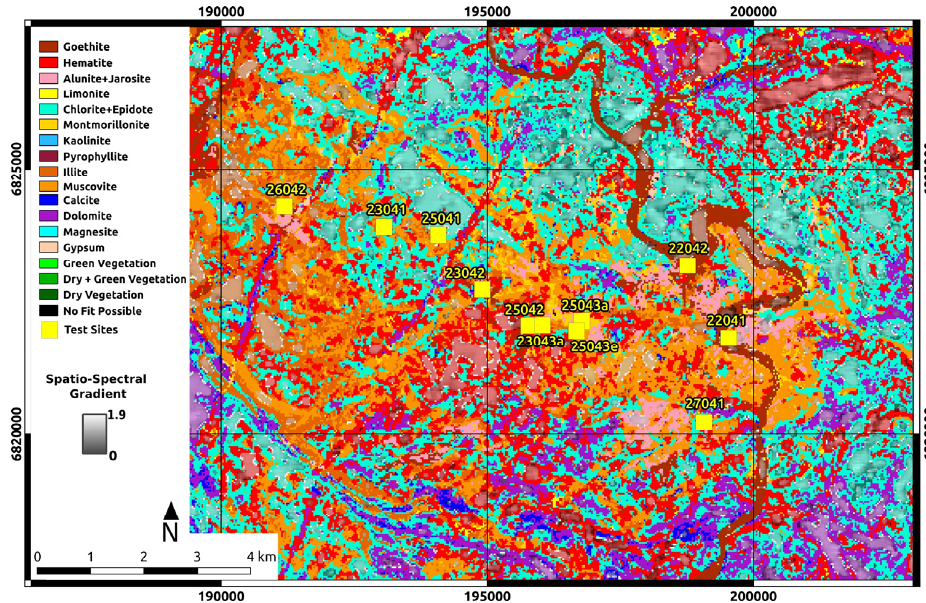
Figure 14. EnGeoMAP 2.0 best fit material map calculated from simulated EnMAP data, using sensor dependent absorption depth thresholding. The semi-transparent overlay shows the spatio-spectral gradient. Prominent gradient edge pixel shown as non-transparent rim pixel around the semi-transparent gradient patches.